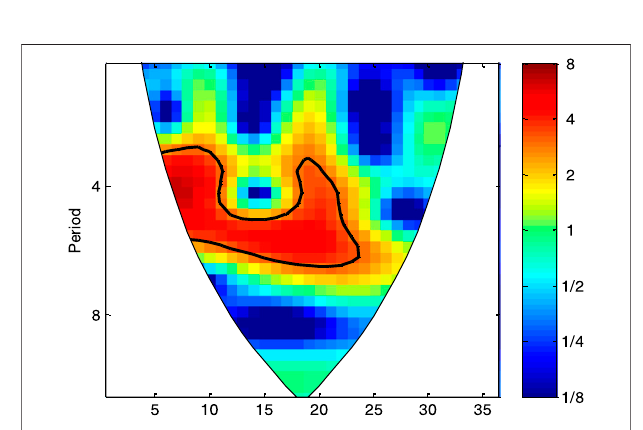
FIGURE 15 | Wavelet analysis of the nino3 index for the period 1979 –